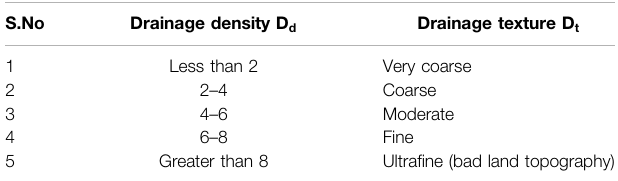
TABLE 7 | Drainage texture classifcation based on drainage density value (Smith,